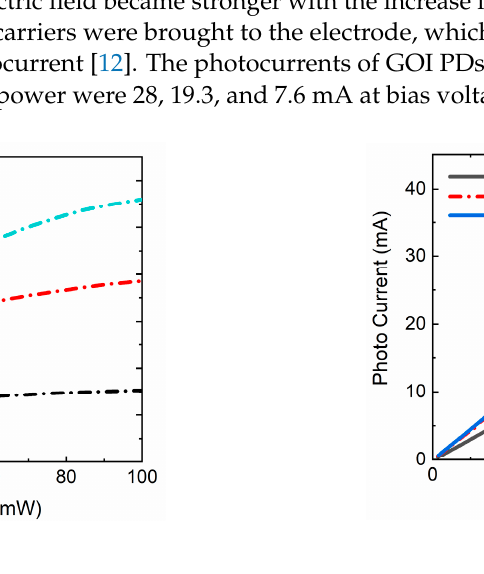
Figure 6. ( a ) Saturated photocurrent curves of the GOI PD without TEOS with 80 μ m diameter at bias voltages of 0, − 1, and − 2 V. ( b ) Saturated photocurrent curves of the normal Ge-on-Si photodetector, GOI PD without TEOS, and GOI PD with TEOS at − 1 V.